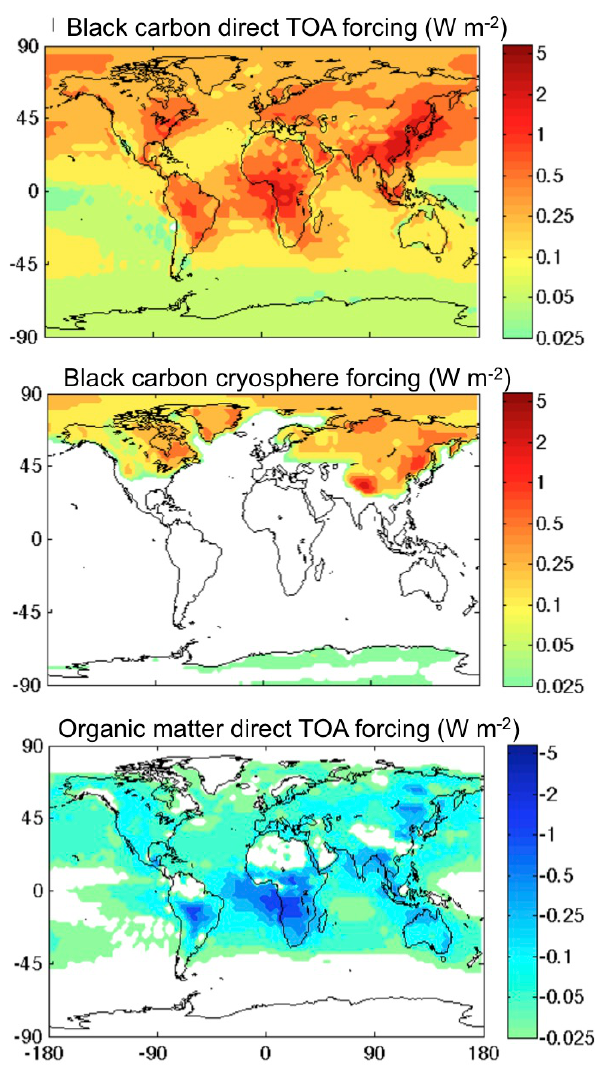
Fig. 3. Forcing by black carbon in atmosphere and on snow, and by organic matter, simulated with the Community Atmosphere